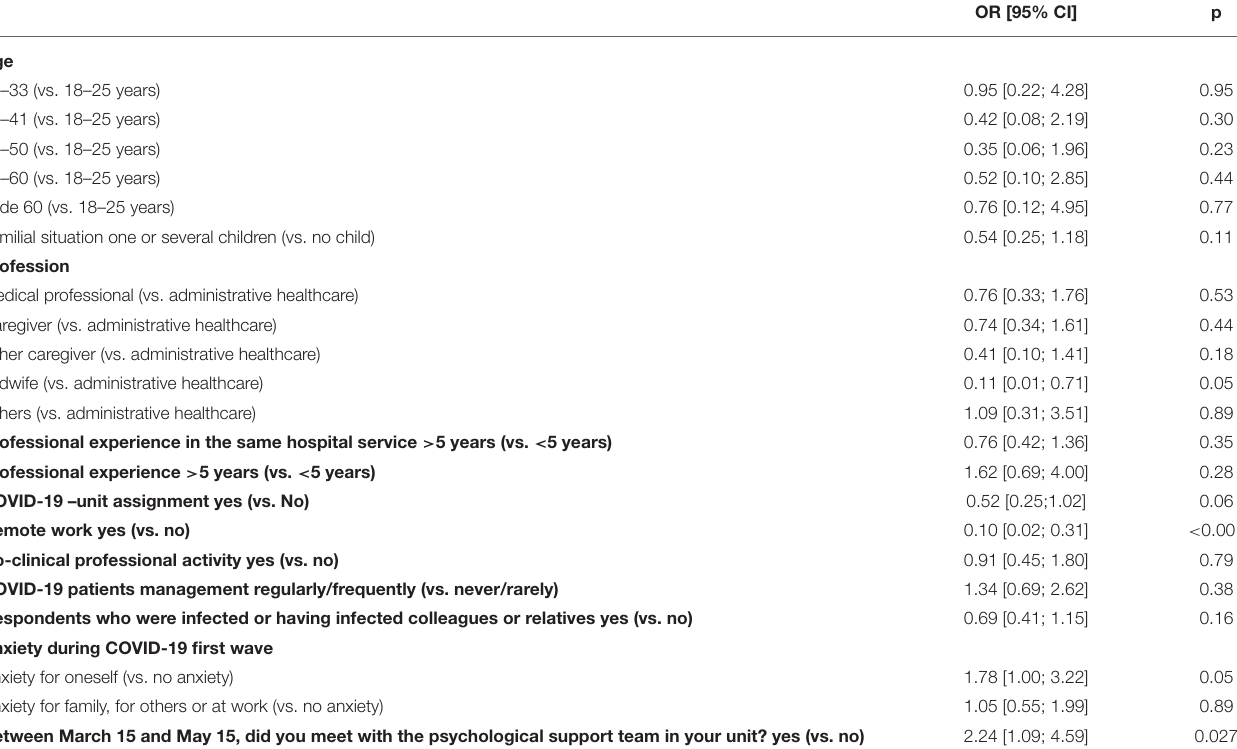
TABLE 2 | Multivariable logistic regression analysis of characteristics of employees associated with access to the Bulle